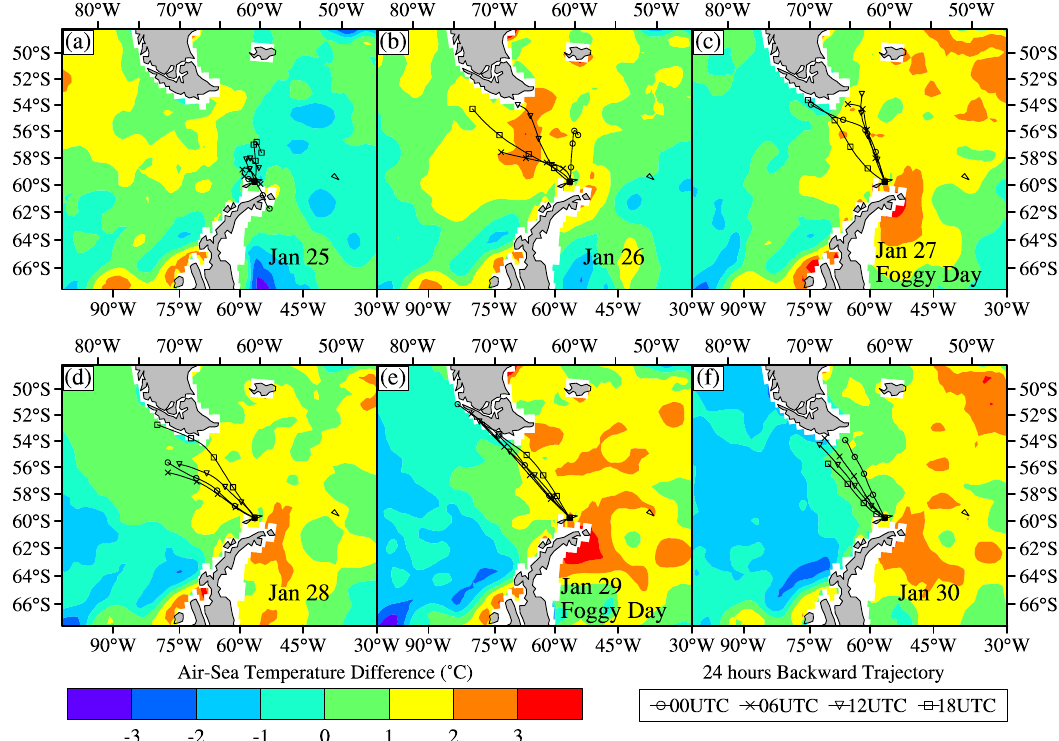
Figure 5. Composite map of air-sea temperature differences (color shading) and 24 h backward trajectories (marked line) from 25 January to 30 January 2017 ( a – f ).